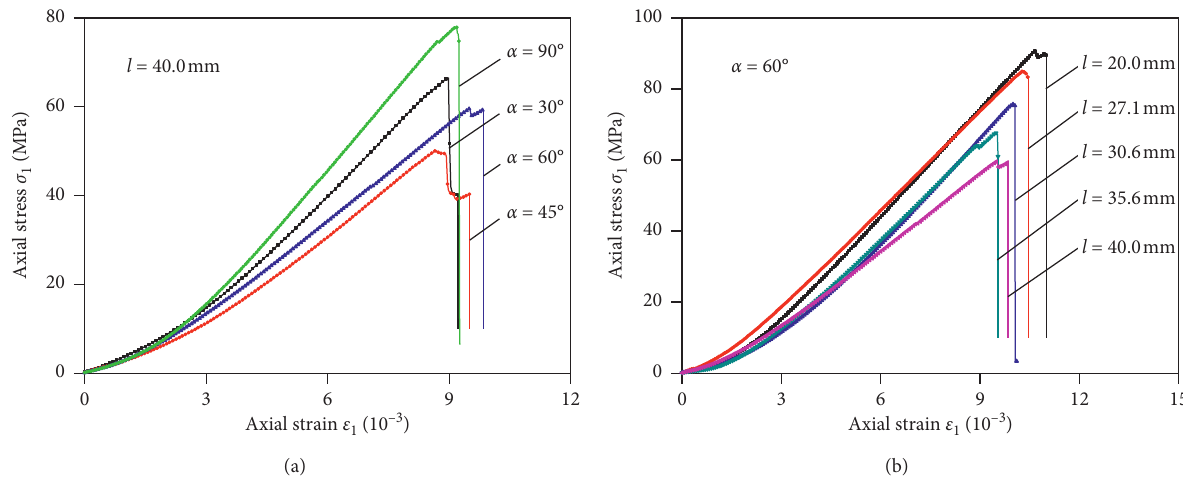
Figure 6: Stress-strain curves of specimens containing rough joint with different (a) joint inclinations and (b) joint